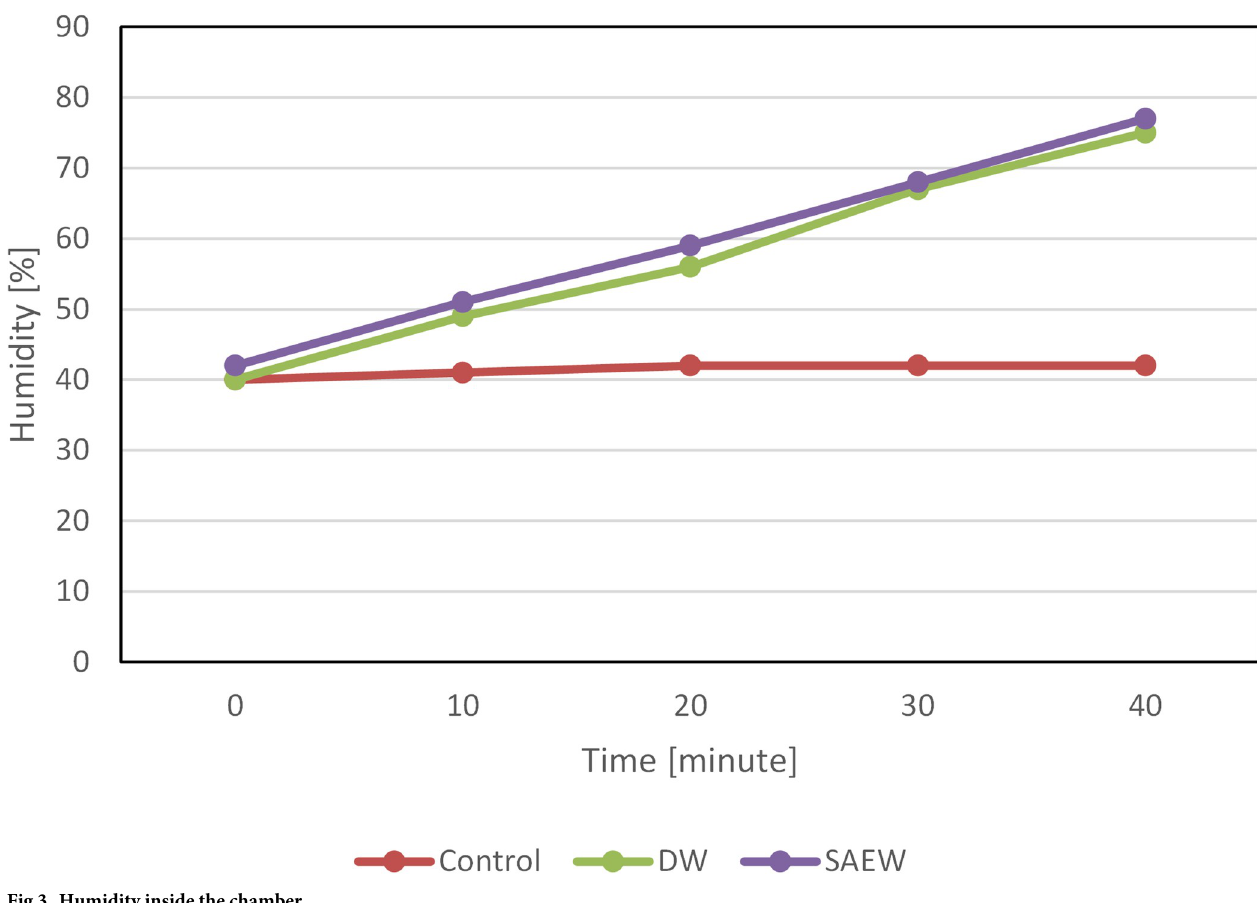
Fig 3. Humidity inside the